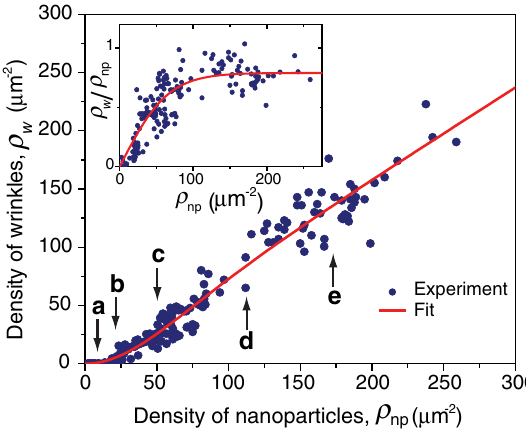
FIG. 4. The density of wrinkles (cid:2) and the mean number of w =(cid:2) (inset) as functions of nano- wrinkles per protrusion (cid:2) w np . Each arrow corresponds to the AFM images particle density (cid:2) np shown in Figs. 1(a)–1(e). The solid red lines are fits described in